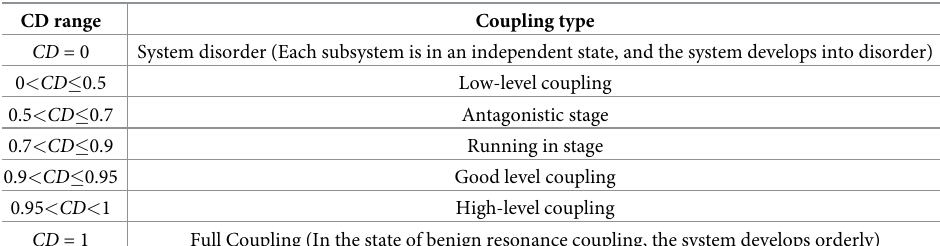
Table 3. Evaluation criteria for CD. CD range Coupling